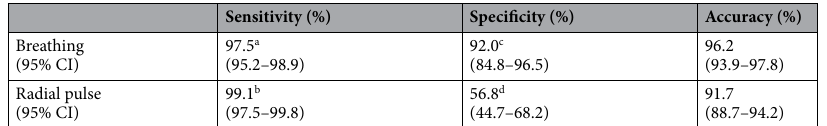
Sensitivity (%) Specificity (%) Accuracy (%)